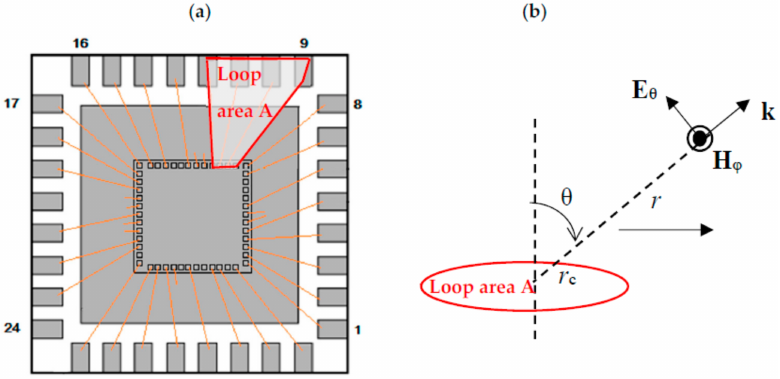
Figure 4. Details for the model of radiated emission from IC: ( a ) a loop of current flowing from the IC into the package; and ( b ) the reference system for the far-field emission from a loop current (magnetic